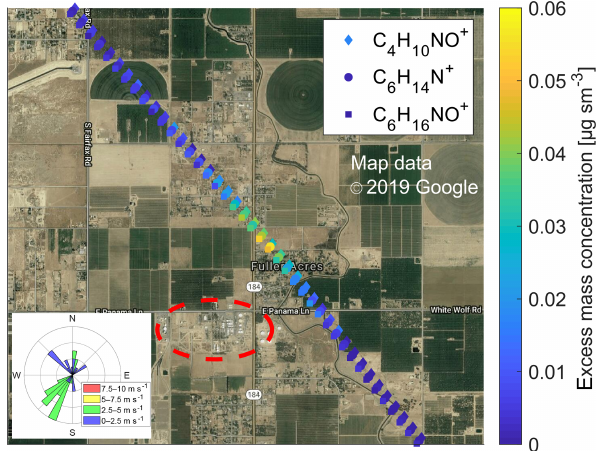
Figure 3. Spatial plot showing the concentration enhance- ments of C 4 H 10 NO + ( m/z 88 . 076), C 6 H 14 N + ( m/z 100 . 112) and C 6 H 16 NO + ( m/z 118 . 122) ions (data points slightly displaced for better visibility) in the particle mass spectra recorded at 1Hz in a plume emanating from a petroleum refinery (circled in red) located in Kern County, SE of Bakersfield, California. The insert shows that the predominant wind direction during this flight transect was from the SSW. In the main text, we link these observations to the emis- sion of an alkanolamine used for gas